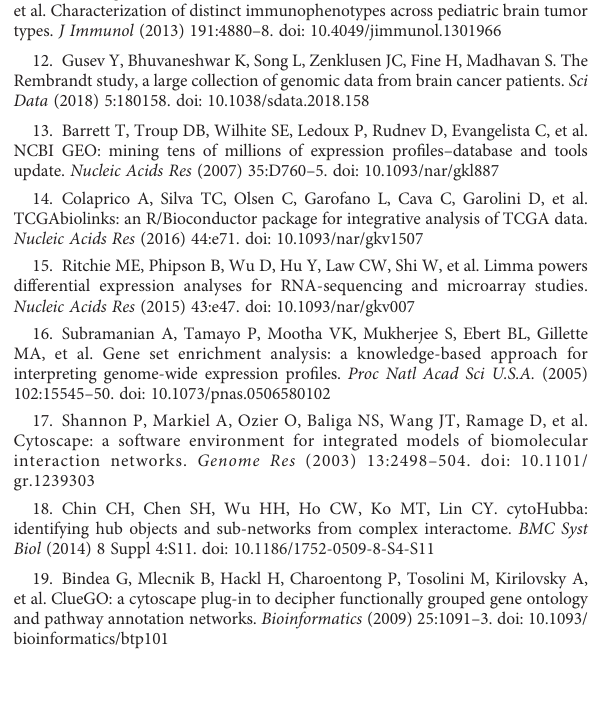
SUPPLEMENTARY FIGURE 1 Differentially expressed genes (DEGs) in gliomas. (A – C) The overall distribution of gene expression differences was visualized using volcano plots. (D – F) The DEGs of each group can distinguish tumor tissues from normal tissues well. SUPPLEMENTARY FIGURE 2 Differentially expressed genes (DEGs) associated with TRAF3IP3 in gliomas. (A) Differential analysis between TRAF3IP3 high expression group and TRAF3IP3 low expression group in glioma tissue. (B) DEGs between the TRAF3IP3 high and TRAF3IP3 low expression groups in the glioma tissues were divided into two groups. DEGs can distinguish between the two